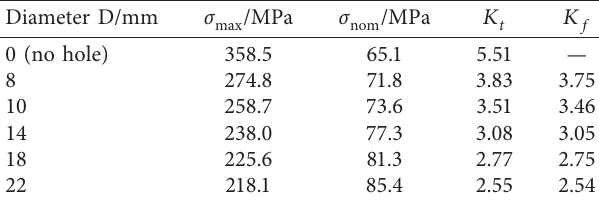
Table 2: K t and K f of stop-hole model under different diameters. Diameter